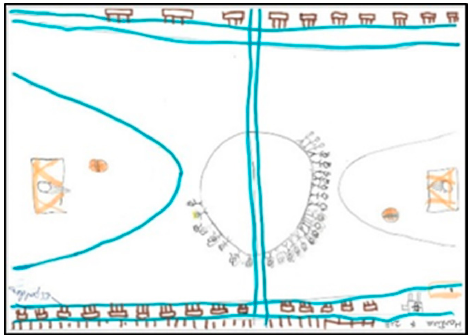
Figure 15. Number of figures present. Laura. 2°B.